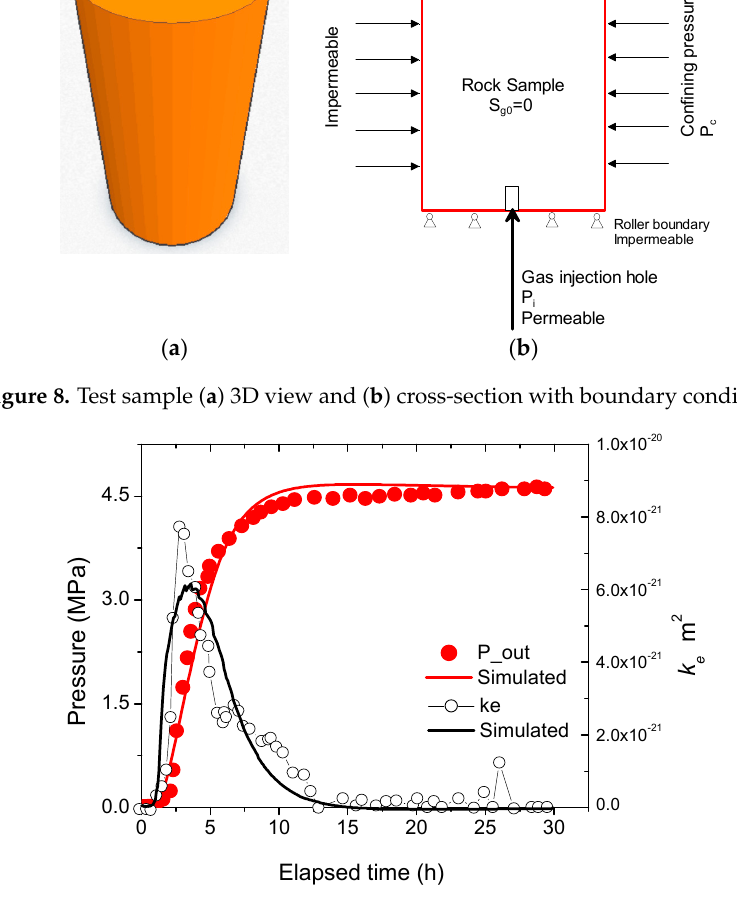
Figure 9. Comparison of test data and simulated curve with respect to the evolution of gas pressure and effective permeability for CO 2 (k e ) (source: Reference [47]).